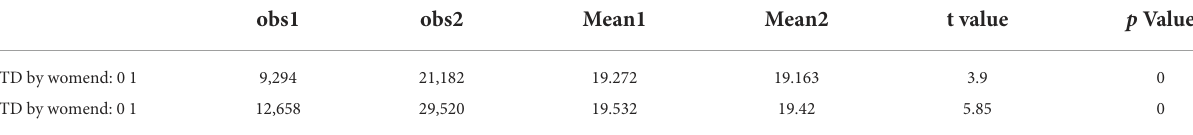
TABLE 4 Two-sample t test with equal